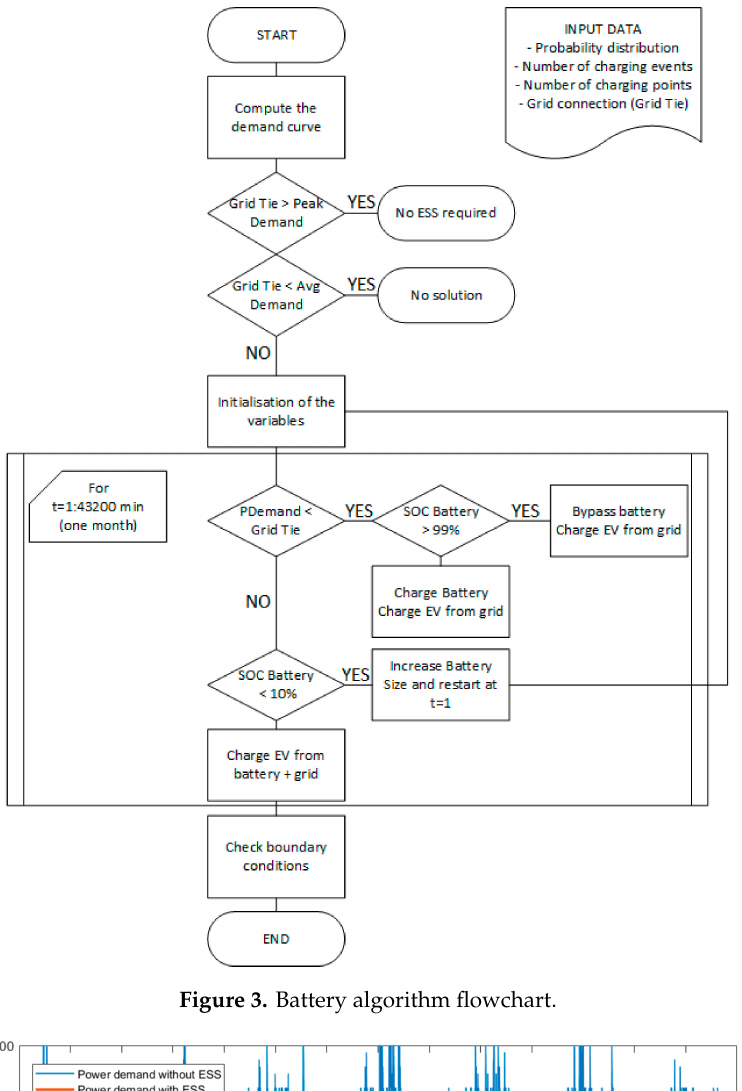
Figure 3. Battery algorithm flowchart.